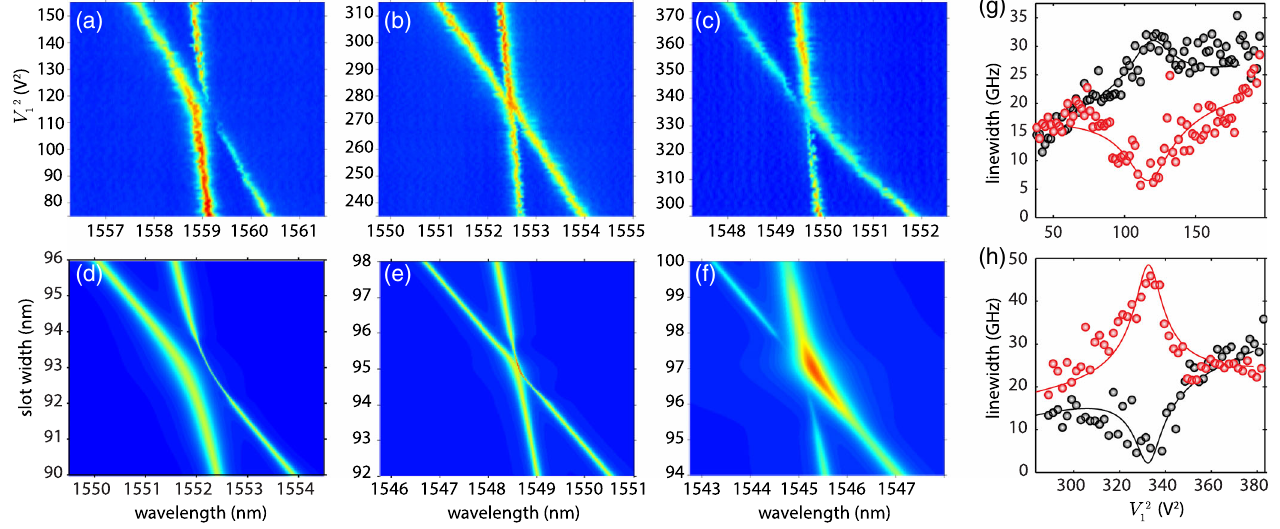
FIG. 4. (a) – (c) Optical transmission measurements versus the wavelength of the probe laser showing the cavity mode anticrossing and tuning of the photon tunneling rate. In these measurements the probe laser wavelength (horizontal axis) is scanned across the optical cavity resonances as the voltage across the first capacitor V 1 is swept from low to high (vertical axis shows V 2 1 in V 2 , proportional to slab displacement). The second capacitor is held fixed at (a) V 2 ¼ 1 V, (b) V 2 ¼ 15 V, and (c) V 2 ¼ 18 V. The color scale indicates the fractional change in the optical transmission level Δ T , with blue corresponding to Δ T ¼ 0 and red corresponding to Δ T ≈ 0 . 25 . From the three anticrossing curves we measure a splitting 2 J= 2 π equal to (a) 50 GHz, (b) 12 GHz, and (c) − 25 GHz. (d) – (f) Corresponding simulations of the normalized optical transmission spectra for the slot width s 1 varied and the second slot width held fixed at (d) s 2 ¼ 93 nm, (e) s 2 ¼ 95 nm, and (f) s 2 ¼ 97 nm. The dispersion and tunneling rate of the slot modes are taken from simulations similar to that found in Fig. 3. Panels (g) and (h) show the measured linewidths of the high-frequency upper (black) and low-frequency lower (red) optical resonance branches as a function of V 2 1 , extracted from (a) and (c), respectively. The narrowing (broadening) is a characteristic of the odd (even) nature of the cavity supermode, indicating the inversion of the even and odd supermodes for the two voltage conditions V 2 ¼ 1 V and V 2 ¼ 18 V. The lines are guides for the eye.